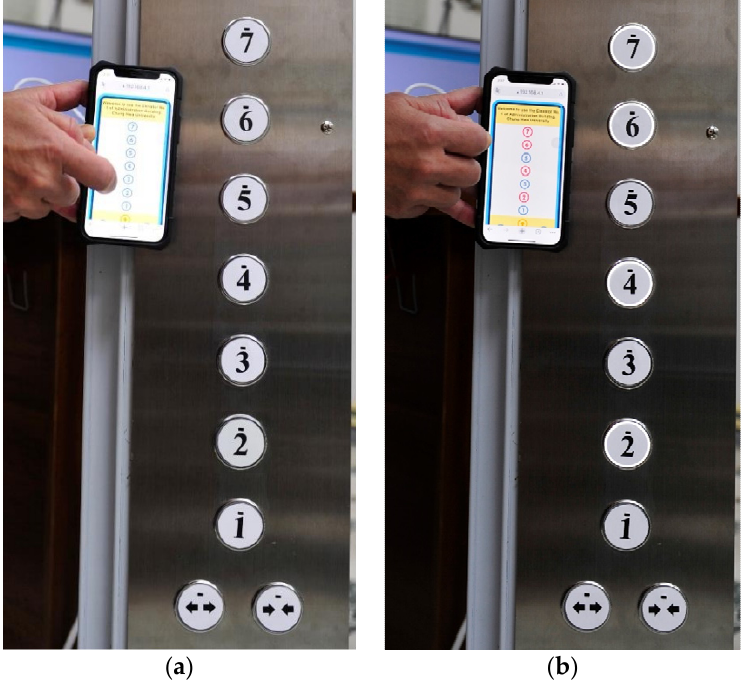
Figure 19. Control the floor to be reached with the mobile browser. ( a ) The floor button of the mobile phone has not been touched; ( b ) 2F, 4F, 6F and 7F of the mobile phone are touched.